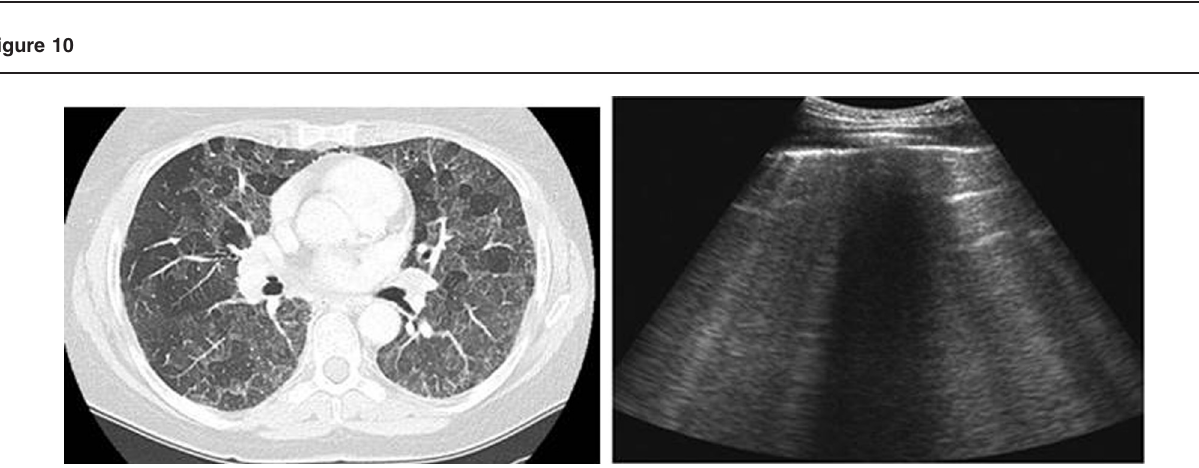
HRCT of the chest showed subpleural reticulation with honey combing. Ultrasound of the same patient showed diffuse B-lines with a wide distance between them (about 7mm). HRCT, high-resolution computed